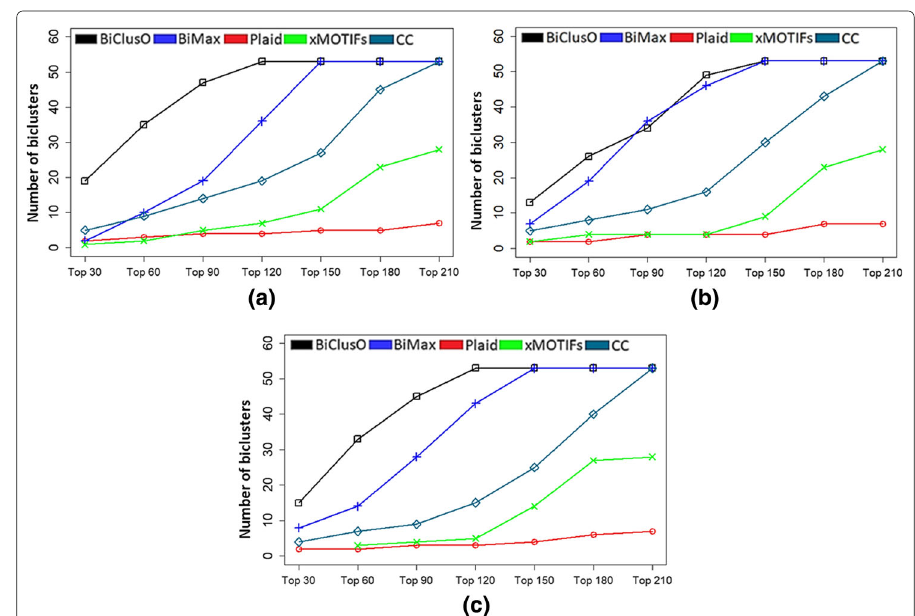
Fig. 6 Performance of different algorithm based on gene expression data of S.cerevisiae . a Ranking based on BP. b Ranking based on CC. c Ranking based on MF Classification of species based on VOCs